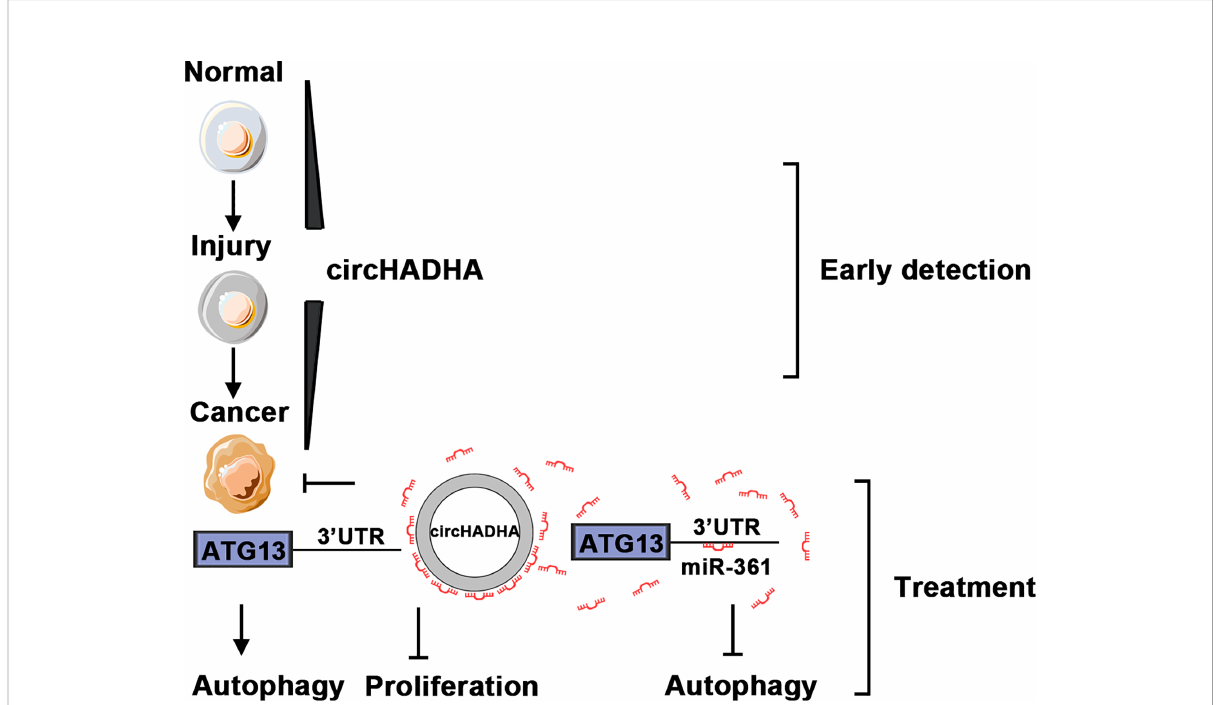
FIGURE 8 The schematic diagram of circHADHA as a potential biomarker for early detection and treatment of colon cancer. The expression of circHADHA increased in the plasma from colon polyp patients compared to healthy individuals, while it was reduced in the plasma from colon cancer patients compared to polyp patients. The dynamic expressions of plasma circHADHA imply a possibility of a novel noninvasive marker in the early detection of colon cancer. CircHADHA improved autophagy regulated by miR-361 and ATG13 in both colon epithelial and cancer cells that indicated an important role of circHADHA in protecting intestinal epithelial cells from injury. The circHADHA-augmented autophagy impeded cell proliferation mediated by miR-361/ATG13 in colon cancer that depicted a potential of circHADHA to act as a therapeutic target for colon